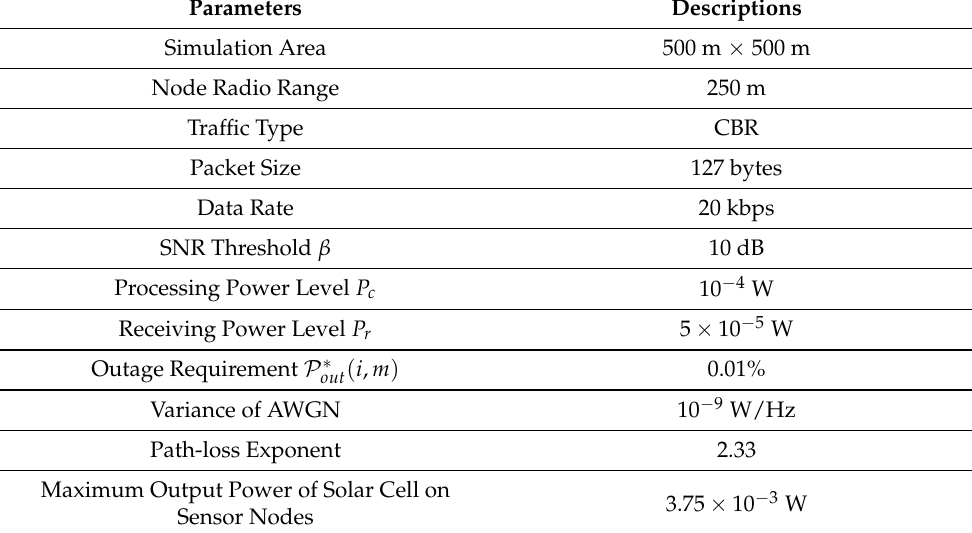
Table 6. Simulation